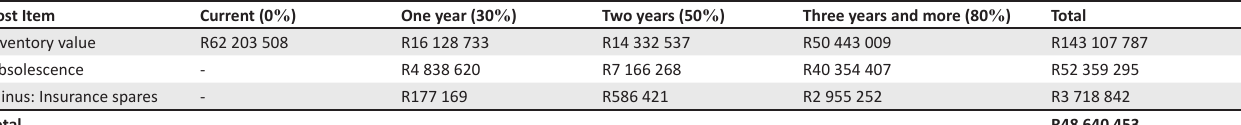
TABLE 2: Calculation of obsolescence